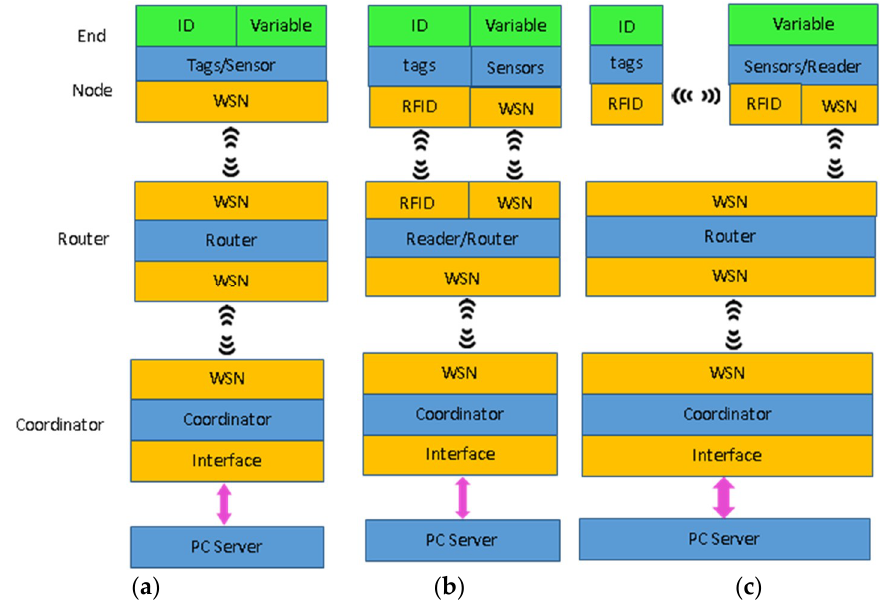
Figure 1. The integration structure of Radio Frequency Identification (RFID) and Wireless Sensor Network (WSN) ( a ) Integration of RFID tags with sensor nodes; ( b ) Integration of RFID readers with sensor nodes; ( c ) Mixed integration.